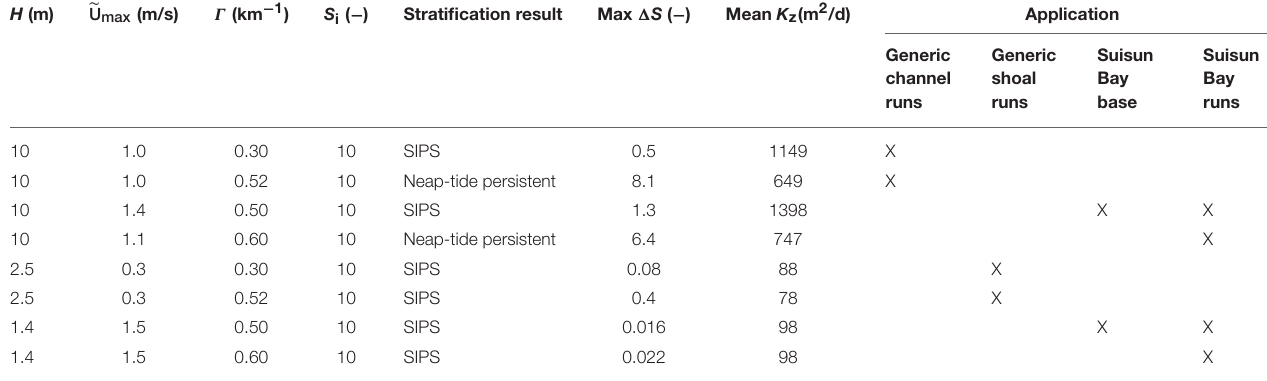
TABLE 3 | Model parameters and scenario descriptions relevant to application of modified BGO (Blumberg et al., 1992) turbulence model for this study. H (m) U max (m/s) Γ (km − 1 ) S i ( − ) Stratification result Max 1 S ( − ) Mean K z (m 2 /d) Application e